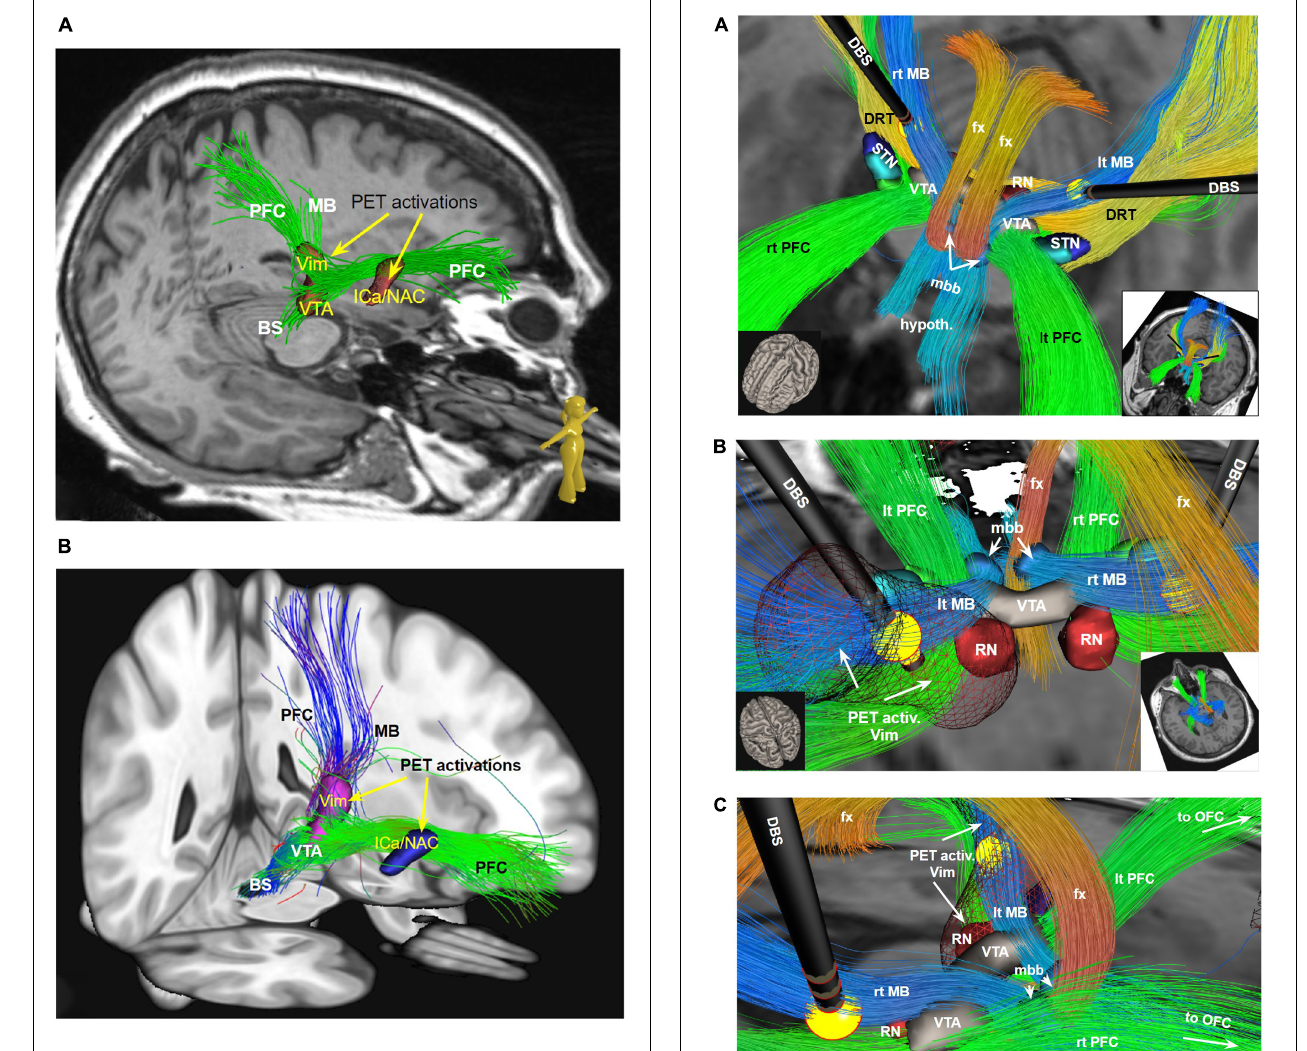
FIGURE 2 | (A) Streamlines selected from global tractography based on the subject’s dMRI data (native space). (B) Same as a but in MNI space and normative dMRI data. Streamlines are constrained to visit the ICa/NAC and the Vim PET activation. MB pathway cannot be visualized in patient individual imaging but shows up on normative data. (MB, mamillary bundle of motorMFB; PFC, prefrontal cortex branch of motorMFB; Vim, ventral intermediate nucleus; VTA, ventral tegmental area; OFC, orbitofrontal cortex; ICa, internal capsule anterior limb; NAC, nucleus accumbens.)